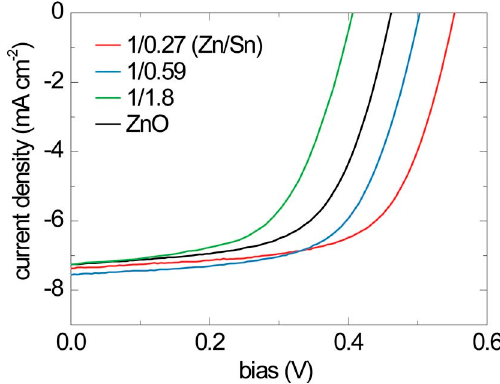
Figure 6. Current density-voltage characteristics of ZnO:Al/a-ZTO/Cu 2 O devices with different composition of ALD buffer layer and no buffer layer under AM 1.5G illumination. Energy Environ. Sci. 2013, 6 , 2112—Published by The Royal Society of Chemistry [35].